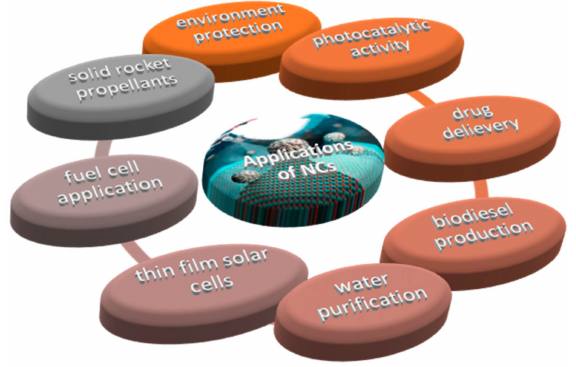
Figure 3. Scopes of metal nanocatalysts.